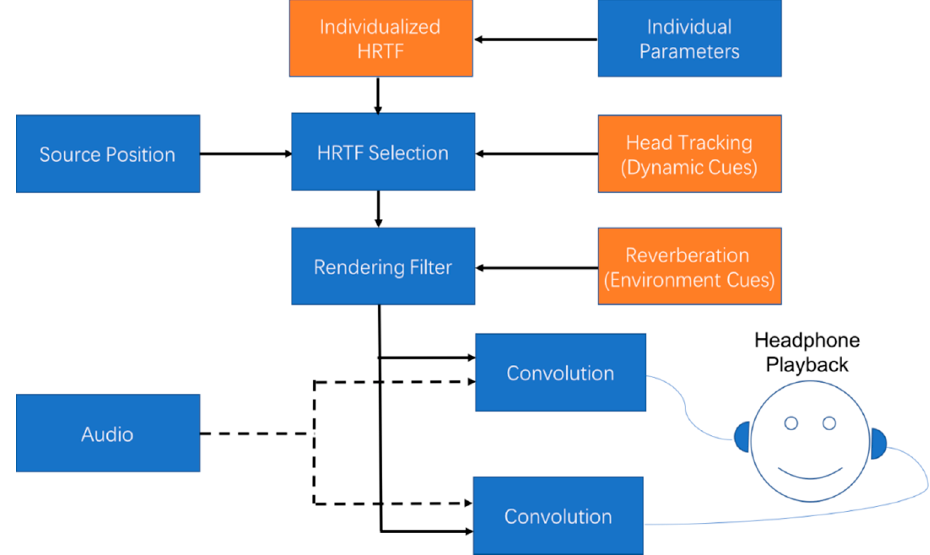
Figure 2. The signal flow of a binaural rendering system.